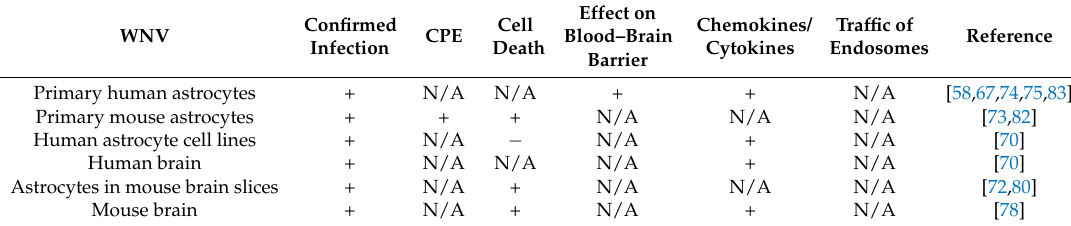
Effect on Chemokines/ Traffic of Cell Confirmed Reference Blood–Brain CPE Death Cytokines Endosomes Infection Barrier